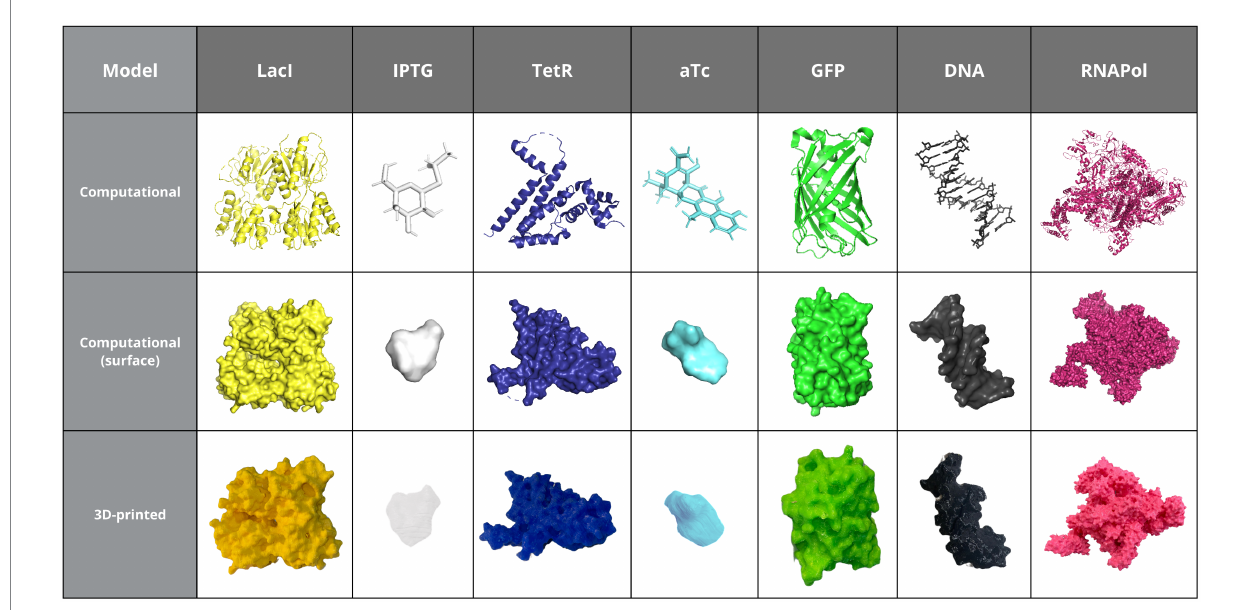
FIGURE 3 Visual comparison of 3D printed models that compose the genetic toggle switch in relation to their respective computational structures.